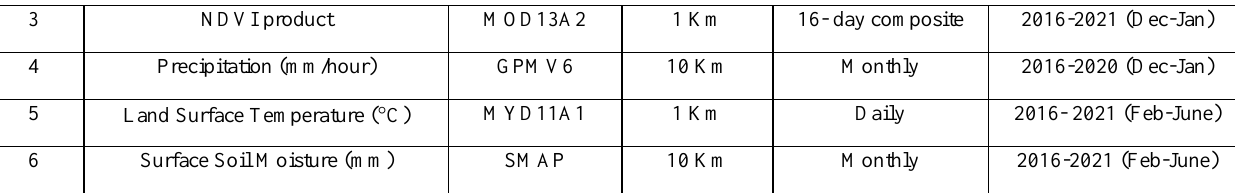
Table 1. Details of the various satellite products used in the study